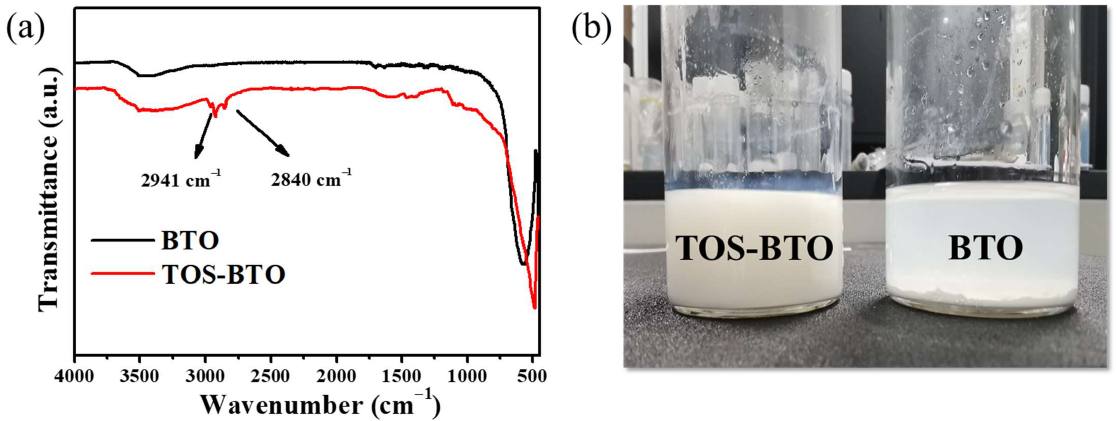
Figure 2. ( a ) FTIR spectra of the BTO and TOS-BTO nanoparticles (inset: chemical structure of the TOS). ( b ) Optical photograph of the TOS-BTO/PVDF and BTO/PVDF inks after 10 d of standing.